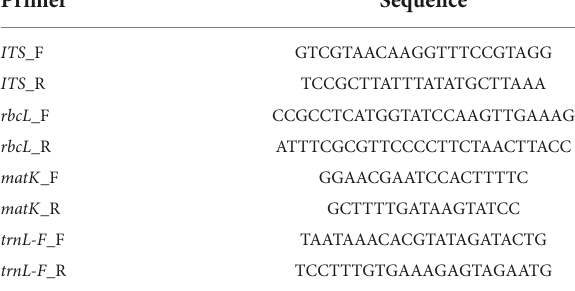
designed using DNAMAN, according to the sequences of three chloroplast genes ( matK , rbcL, and trnL - F ) and one nuclear region ( ITS ) of Agropyron , Bromus , Elymus , Elytrigia , Festuca , Leymus, and Lolium